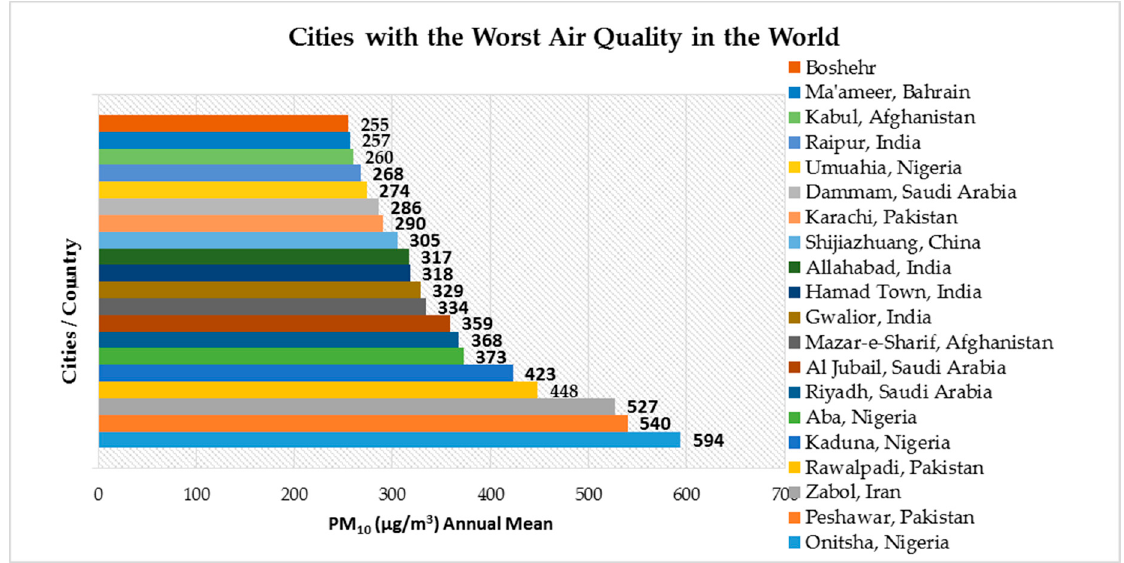
Figure 2. World Health organization (WHO) Urban Ambient Air Pollution Data Base 2016 Update (data only). (data